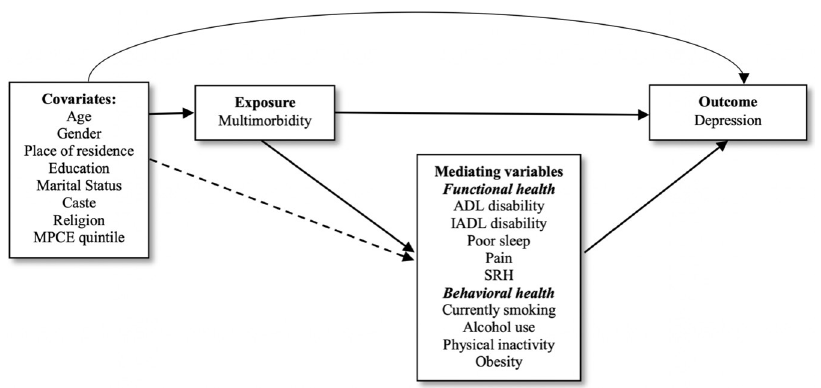
Fig 1. Preliminary theoretical model of the multimorbidity-depression association and its potential